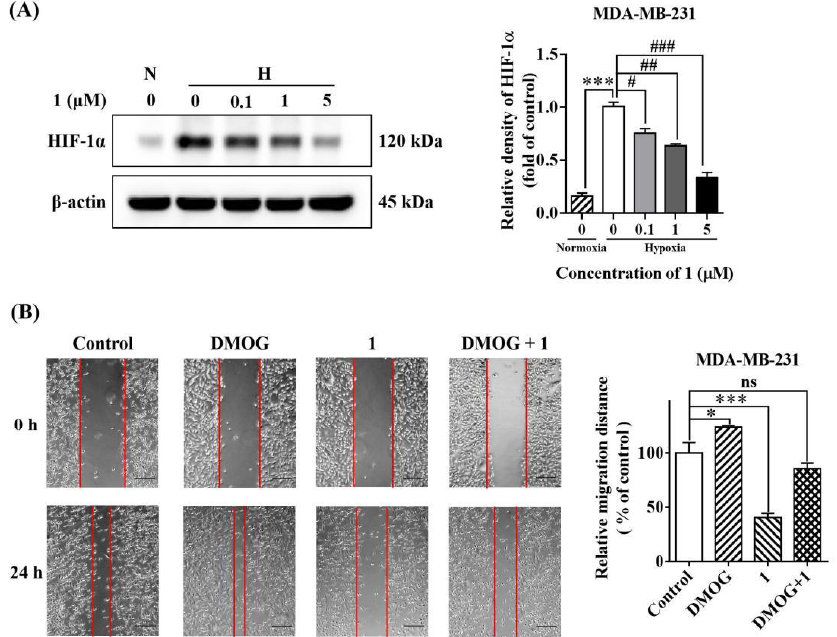
Figure 5. The effect of 1 on cell migration was correlated to HIF- 1α expr ession. Compound 1 inhib- ited HIF-1 α expression under hypoxia ( A ). ( n = 3, means ± SEM are shown; *** p < 0.001, compared with control under normoxia; # p < 0.05, ## p < 0.01, ### p < 0.001, compared with control under hypoxia.) The HIF-1 α agonist DMOG rescued MDA-MB-231 cell migration from the inhibition of 1 ( B ). ( n = 3, means ± SEM are shown; * p < 0.05, *** p < 0.001, compared with